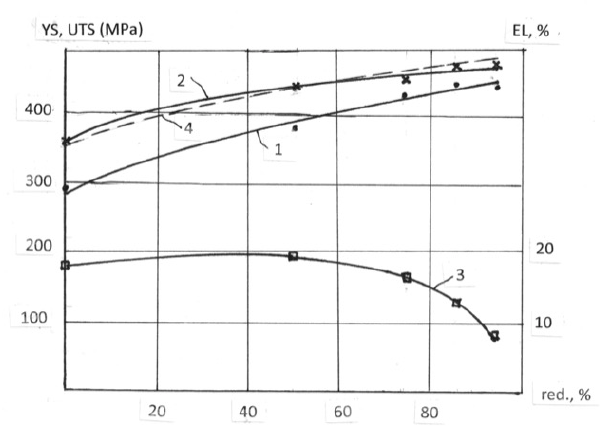
Figure 10. E ff ect of rolling reduction on yield stress (YS), ultimate tensile strength (UTS), and relative elongation (EL) of AA5083: 1—YS of the solution-treated material + four (D) sc-ECAE passes; 2—UTS of the solution-treated material + four (D) sc-ECAE passes; 3—EL of the solution treated material + four (D) sc-ECAE passes; 4—UTS after four (D) discontinuous ECAE passes of the as-received material. Table 2. MechanicalpropertiesofAA5083. YS—yieldstress;